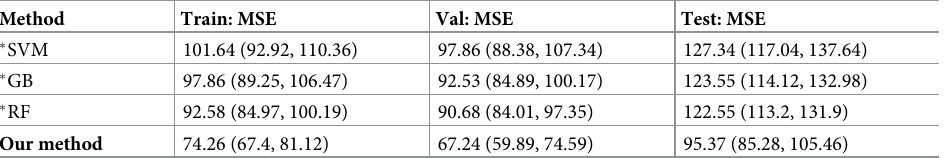
Table 7. The comparison of the MSE values of the proposed CNN method and classical machine learning methods.